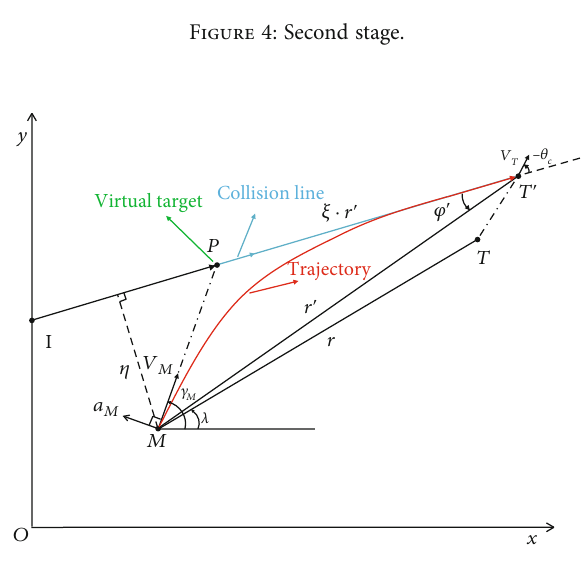
Figure 5: Moving